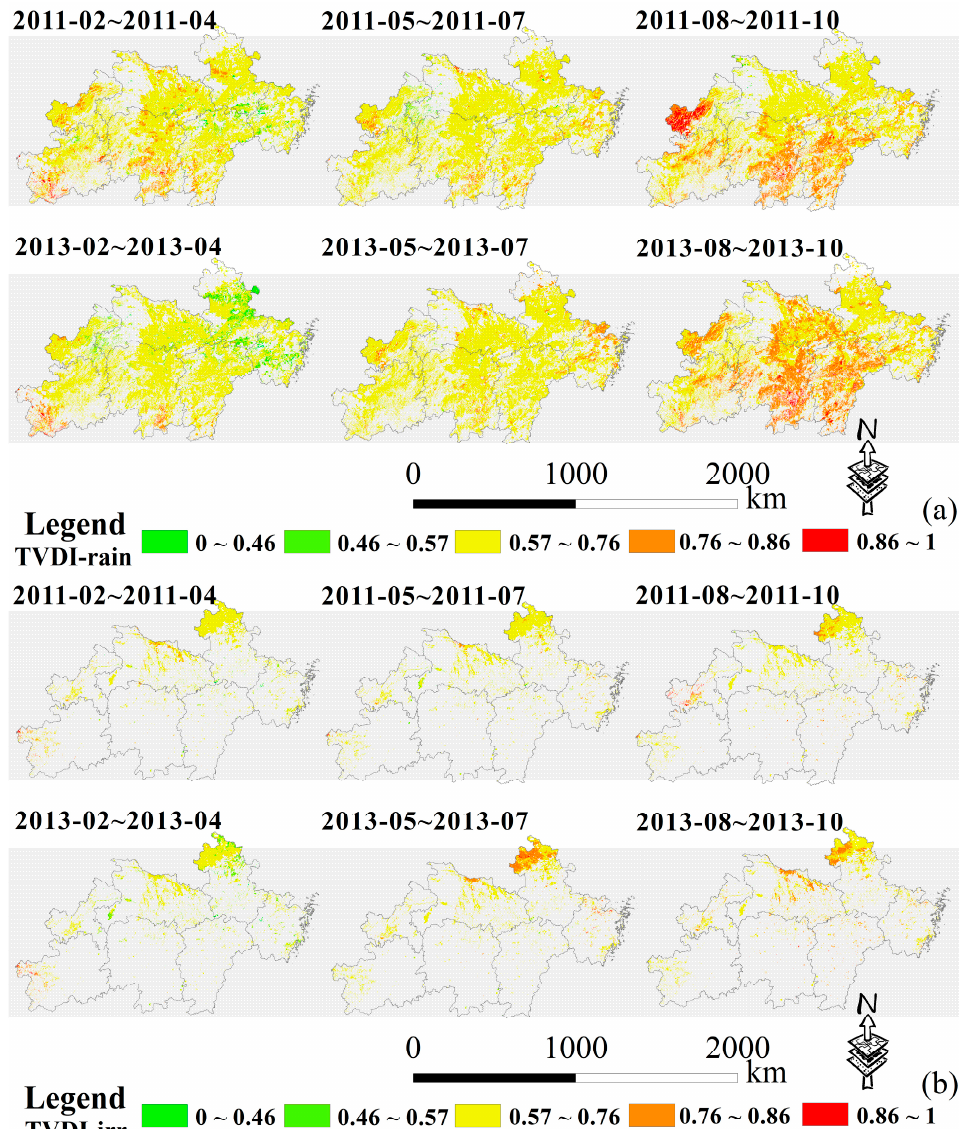
Figure 12. Spatial distribution of 3-month average of the TVDI in the middle and lower reaches of the Yangtze River in China in 2011 and 2013. The images without crop growth in January and December were removed. ( a ) The TVDI of rain-fed arable land (TVDI-rain). ( b ) The TVDI of irrigated arable land (TVDI-irr).